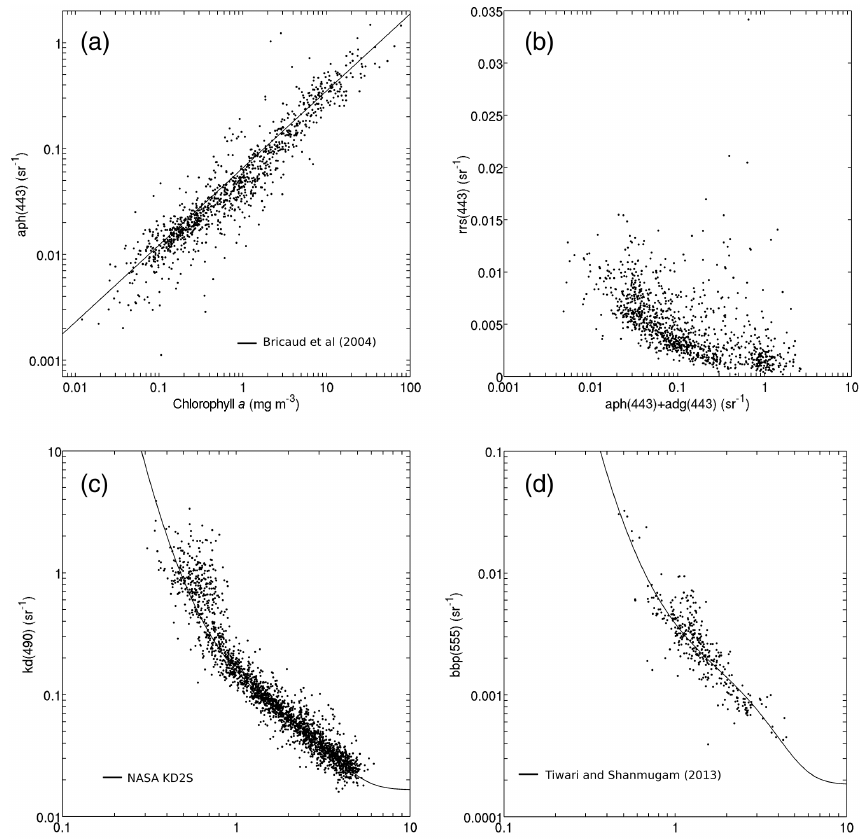
Figure 16. Examples of bio-optical relationships in the final merged table. Panel (a) : aph(443) vs. chlorophyll a . Total number of points (1070) is divided between MERMAID (70), NOMAD (991) and SeaBASS (9). For reference the solid line show the regression from Bricaud et al. (2004). Panel (b) : [aph(443) + adg(443)] vs. rrs(443). Total number of points (1112) is divided between MERMAID (33) and NOMAD (1079). Panel (c) : [rrs(490) / rrs(555)] vs. kd(490). The total number of points (2280) is divided between MERMAID (62), NOMAD (2117) and SeaBASS (101). For reference the solid line show the NASA KD2S standard algorithm (http://oceancolor.gsfc.nasa.gov/cms/atbd/kd_ 490). Panel (d) : [rrs(490) / rrs(555)] vs. bbp(555). The total number of points (357) is divided between MERMAID (33) and NOMAD (324). For reference the solid line show the relation proposed by Tiwari and Shanmugam (2013). A search window of 2nm was used for panels (a) and (b) , and a search window of 5nm was used for panels (c) and (d) to include data at 560nm when not available at